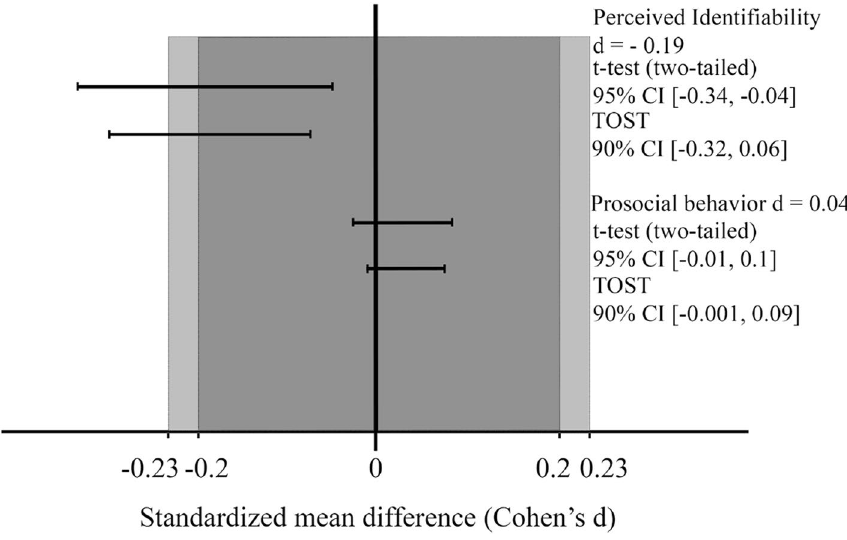
Figure 3. Standardized mean differences for the ‘Mask’ group and the ‘No Mask’ group in Study 2. Note The t-test for perceived identifiability indicates that the difference between the two groups is significantly different from 0. The TOST for perceived identifiability indicates that the difference between the two groups is not significantly smaller than d = 0.2, nor is it smaller than d = 0.23. The t-test for prosocial behavior indicates that the difference between the two groups is non-significantly different from 0. The TOST indicates that the difference between the two groups is significantly smaller than d =